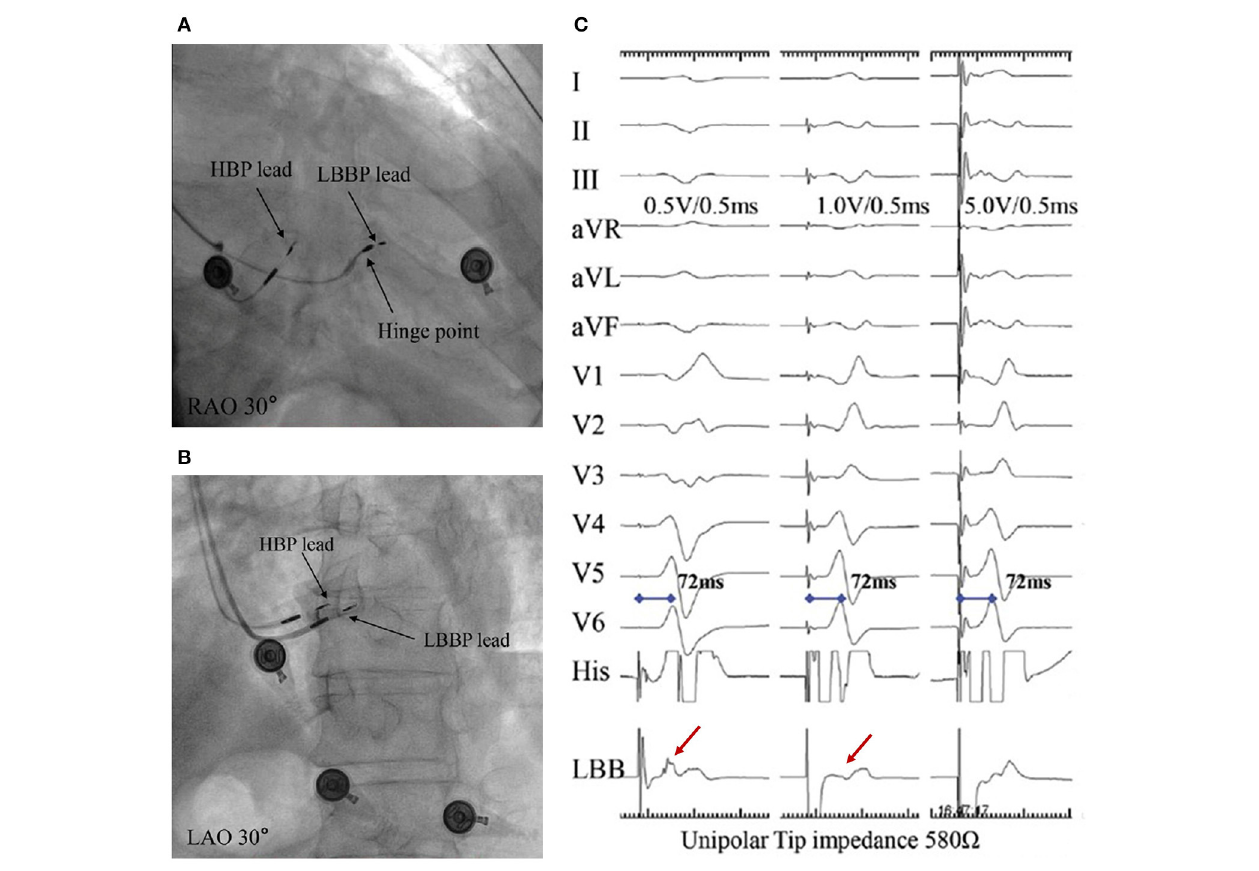
FIGURE 6 | A demonstration of selective and non-selective LBBP and the depth of its lead in the septum. (A) Fulcrum sign. (B) Sheath angiography in the LAO 30 ◦ view demonstrating the depth of the LBBP lead inside the septum. (C) The presence of a discrete local EGM with short pLVAT (72ms) during selective LBBP (first beat). The last two beats indicate a constant pLVAT at different pacing outputs without discrete component, which is considered as non-selective LBBP ( 9). LBBP, left bundle branch pacing; LAO, left anterior oblique; RAO, right anterior oblique; EGM, electrogram; pLVAT, peak left ventricular activation time.